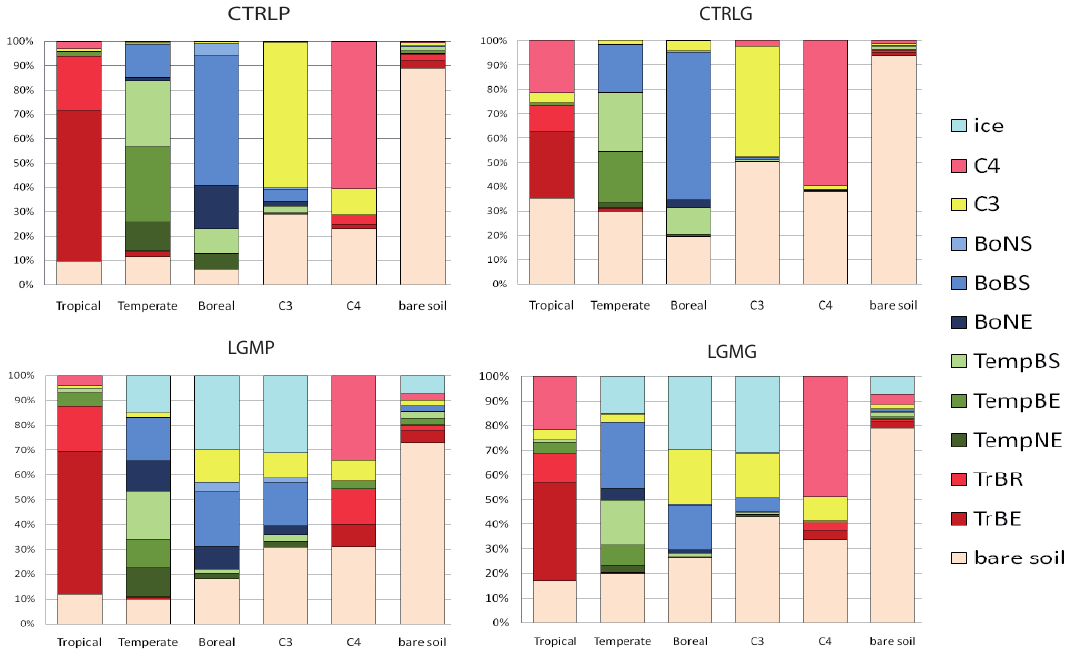
Fig. 6. Detail of the PFT composition in the area of dominance of tropical forests, temperate forests, boreal forests, C3 and C4 grasses, and bare soil in CTRLP. We keep this same area as the reference for CTRLG, LGMP, and LGMG. Abbreviations: see Table